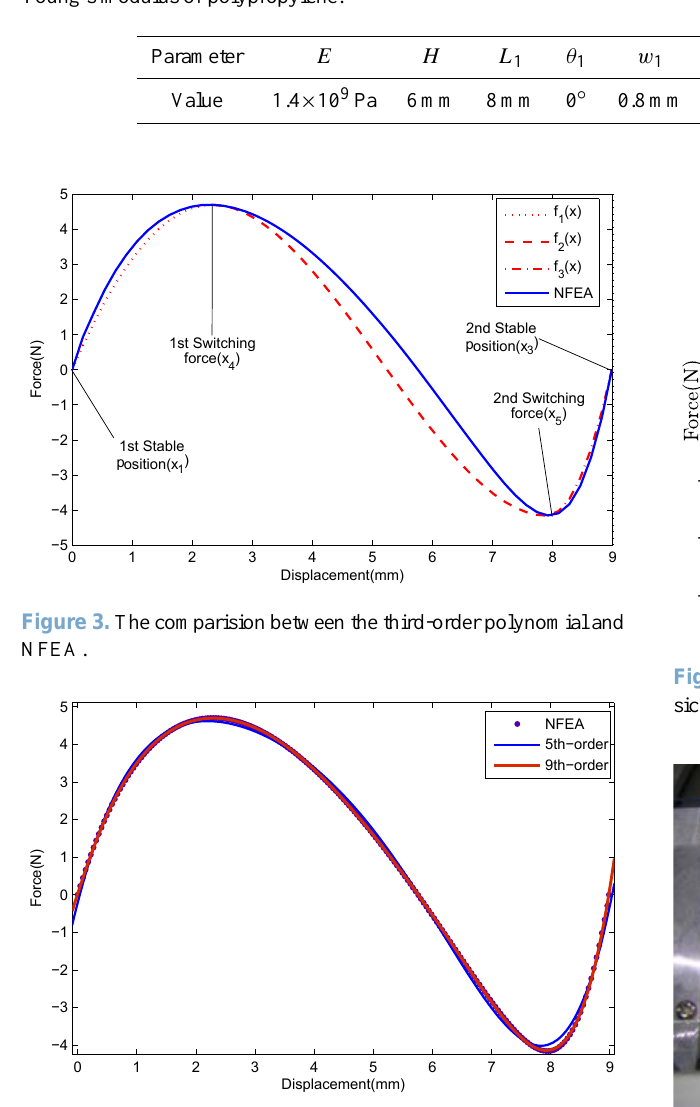
Figure 4. The comparision among the fifth, ninth-order polynomi- als and NFEA.